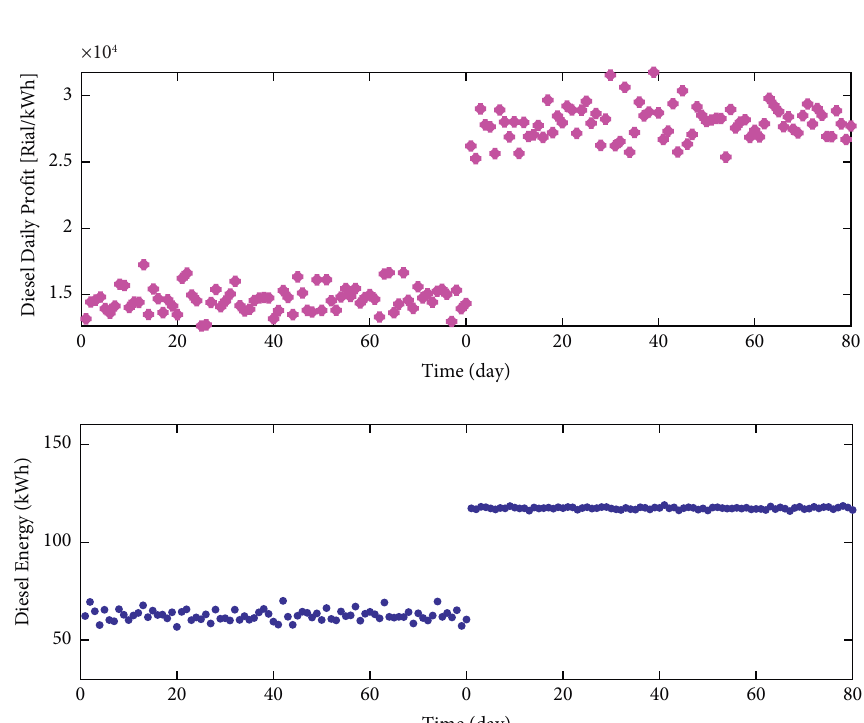
Figure 6: Average daily proft and output power of diesel